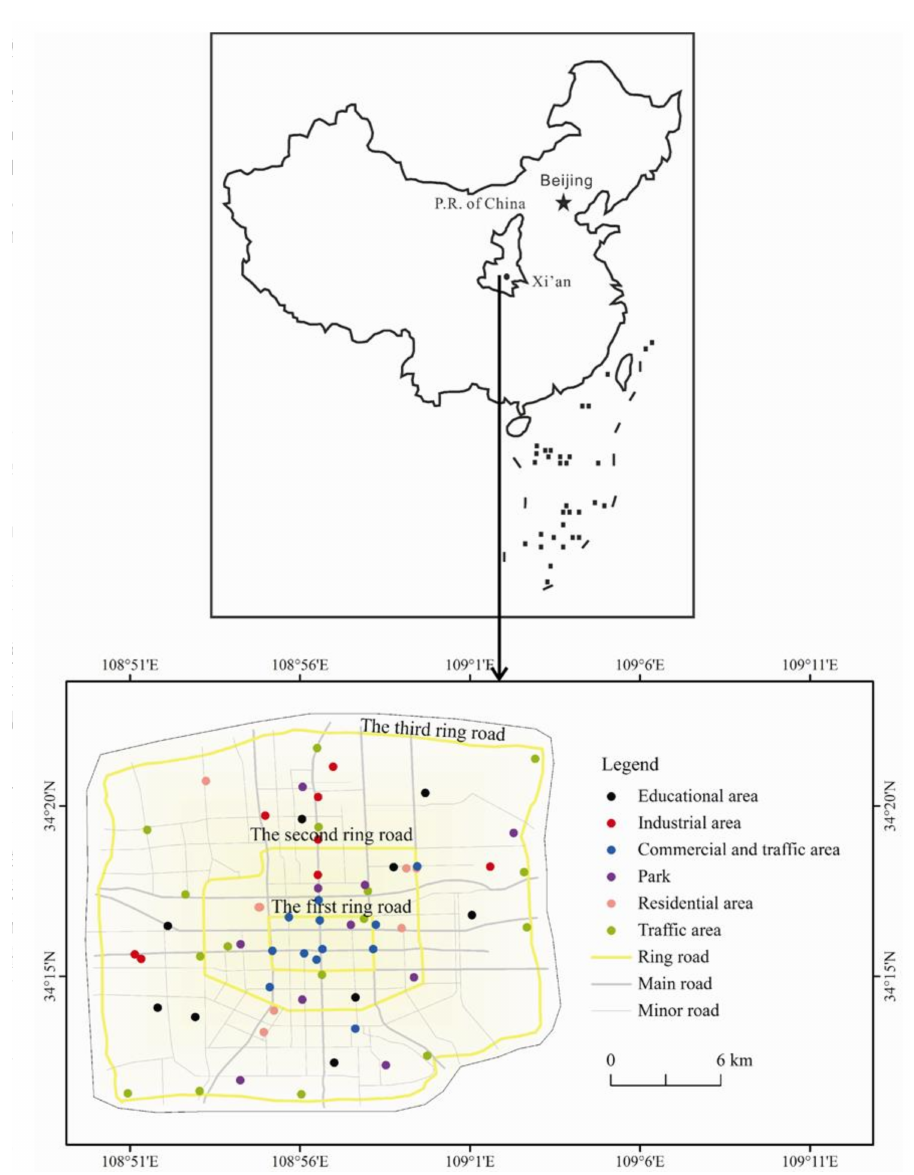
Figure 1. Location of study area and sampling sites of urban soil in